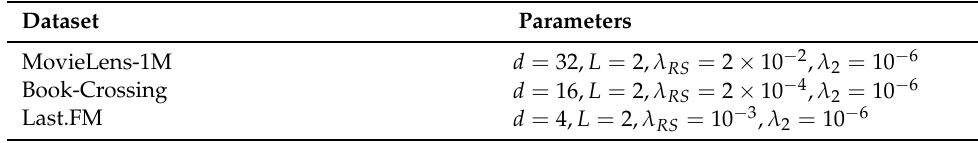
Table 2. Hyperparameter settings for the KCNR